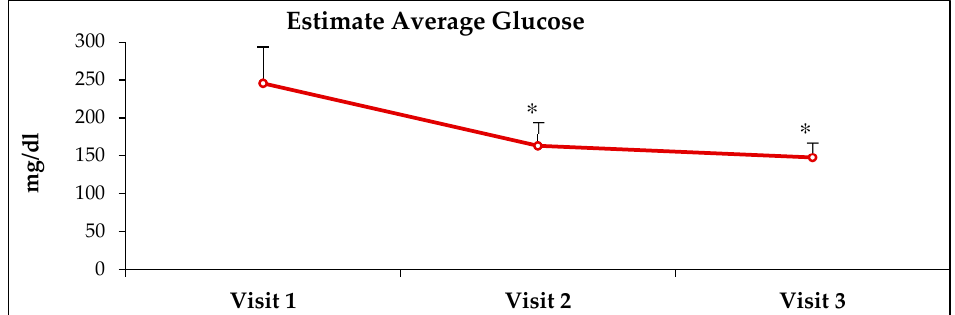
Figure 1. Improvement in glycosylated hemoglobin (HbA1c) after receiving ABCDE. Visit-1 = first visit where ABCDE was provided; Visit-2 and Visit-3 = visits 3- and 6 months after Visit-1. ∗ = p < 0.00001.